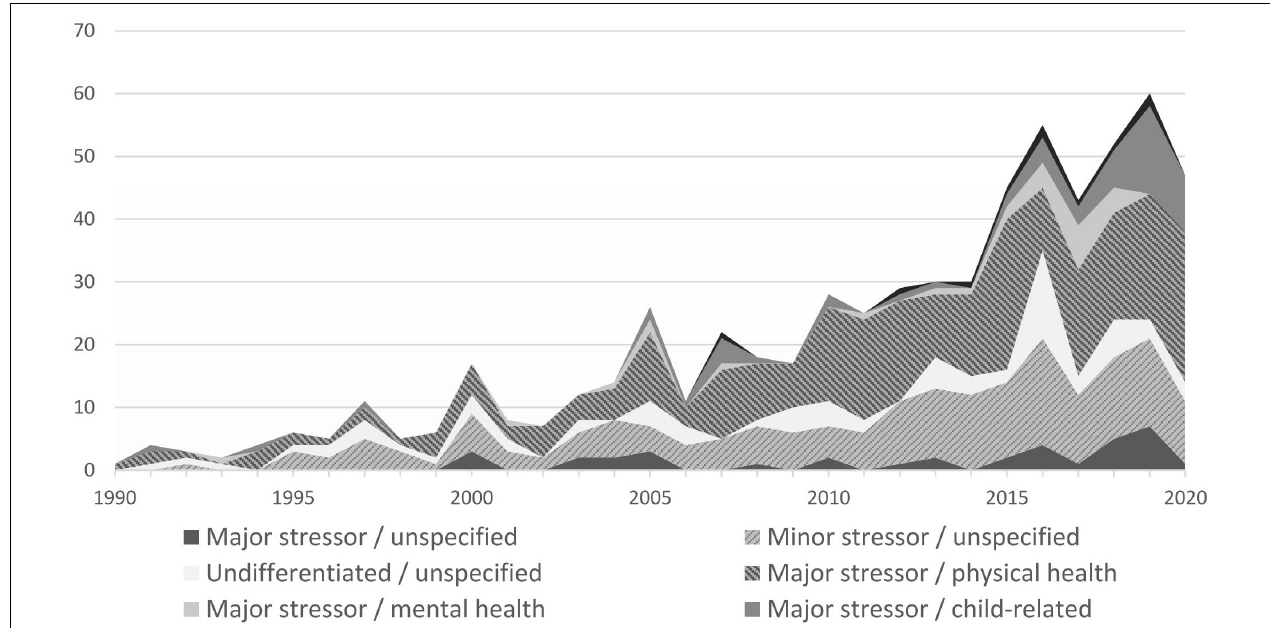
FIGURE 4 | Number of dyadic coping (DC) publications between 1990 and 2020 grouped by types of stressors.